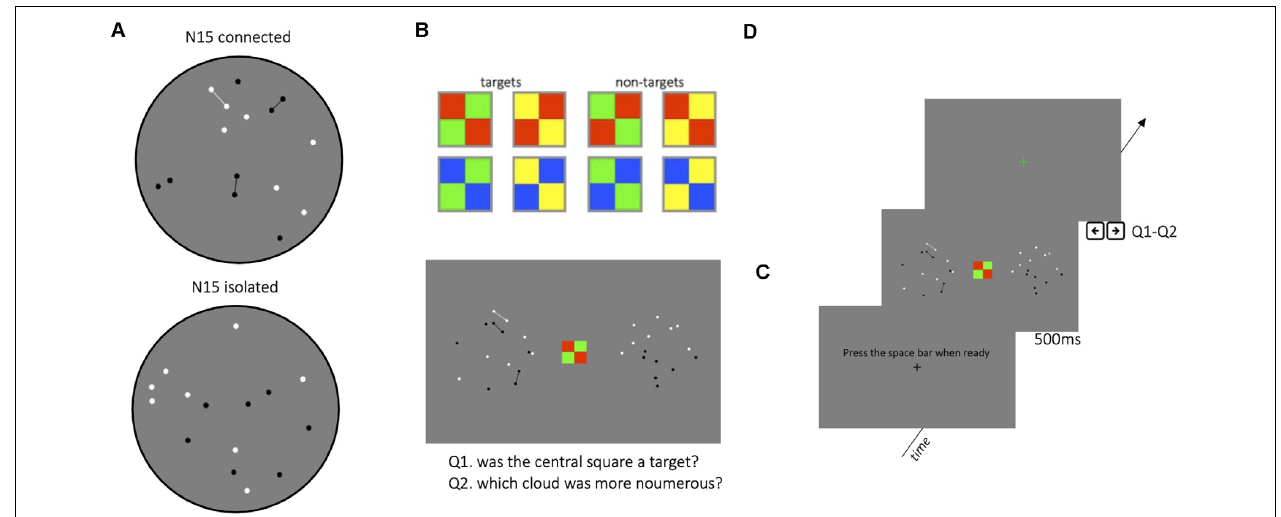
FIGURE 1 | Illustration of the stimuli used in the experiment. (A) Example stimuli showing the connected condition (upper image), with 40% dots connected by thin lines, and the isolated-dot condition (lower image), with the lines, removed. Although both images have the same numerosity (N15), connecting dots with lines clearly causes the patch to appear less numerous. (B) Conjunction stimuli displayed in the center of the screen for the visual-spatial dual-task. The stimulus was a target if it satisfied a specific conjunction of colors and orientations (see the “Apparatus and Stimuli” section for details). (C,D) Example of the procedure with a timeline of a trial. Each trial started with a fixation point, followed by two- dot clouds presented together with the distractor, both for 500 ms. In the dual-task condition, participants responded first to the distractor task and then indicated which of the two clouds of dots seemed more numerous. In the single task, they performed only the numerosity task.